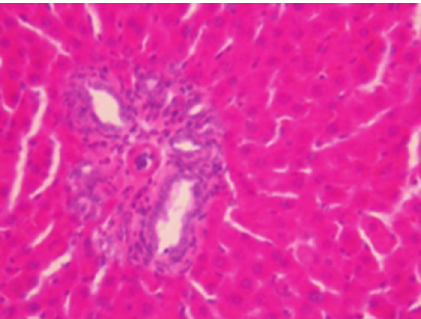
Figure 3: Model-control group 28 days; hyperplasia of small hepatic bile ducts and obvious degeneration of hepatic cells; HE × 200.